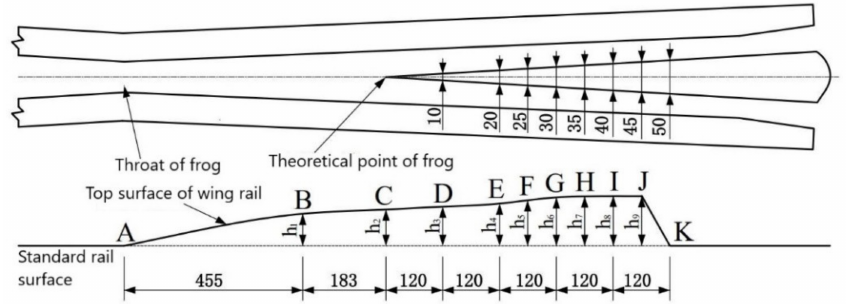
Figure 7. Plan and side view of the wing